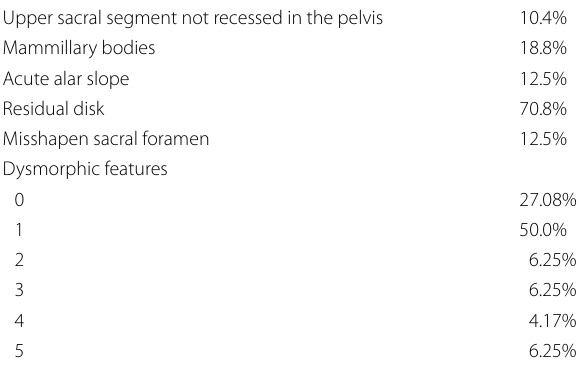
Table 2 Prevalence of dysmorphic sacral features